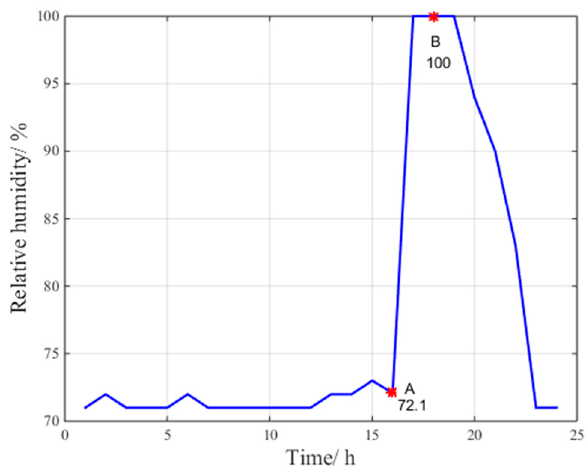
Figure 5. Abnormal relative humidity condition.